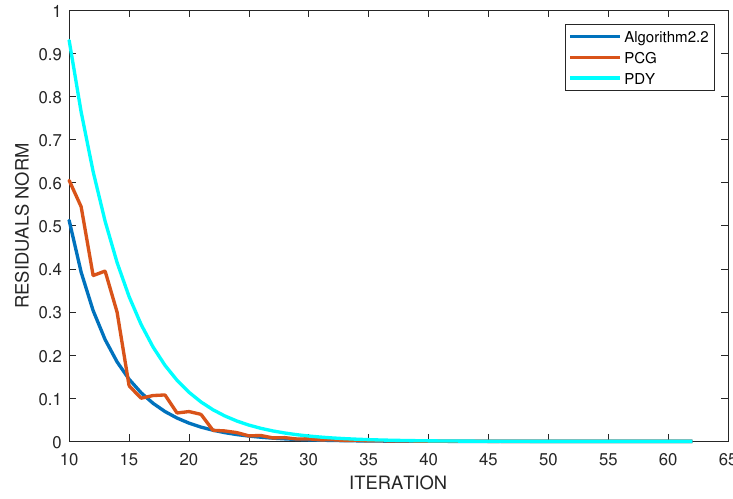
Figure 4. Convergence histories of Algorithm 1, PCG and PDY on Problem